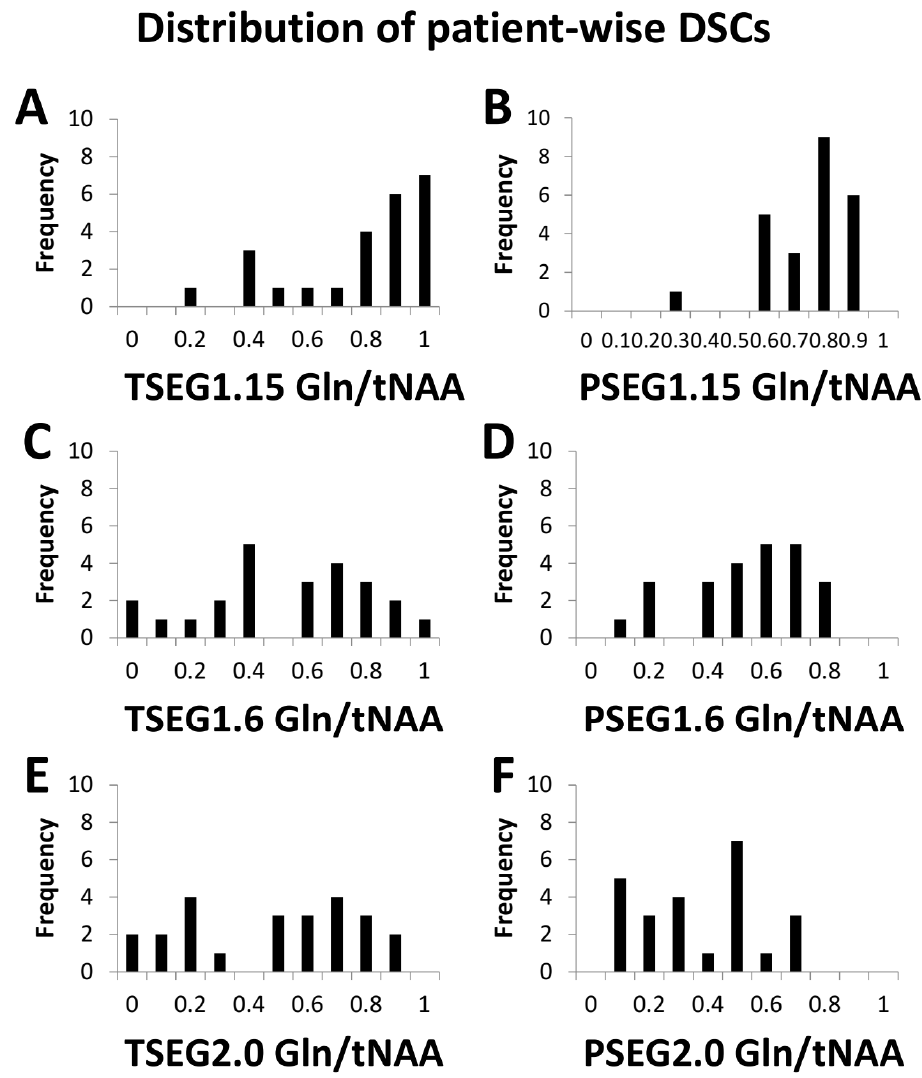
Figure 2. Histograms of the DCSs between PET TBR and Gln/tNAA for all six VOI definitions add to the finding that the TSEG1.15 and PSEG1.15 cases ( A , B ) were not as specific as the other two thresholds. The difference between 1.6 ( C , D ) and 2.0 ( E , F ) as cutoff appeared smaller.